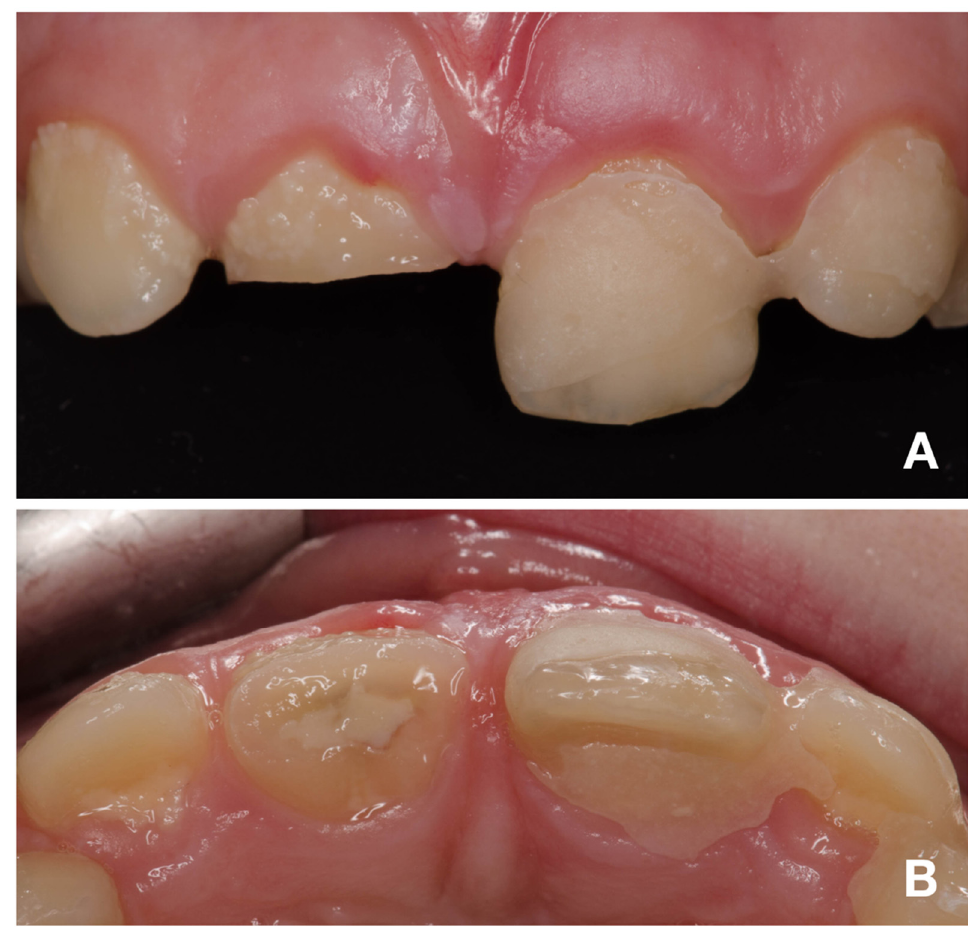
Figure 1. Intraoral photographs of teeth 12–22. ( A )—buccal view; ( B )—occlusal view.